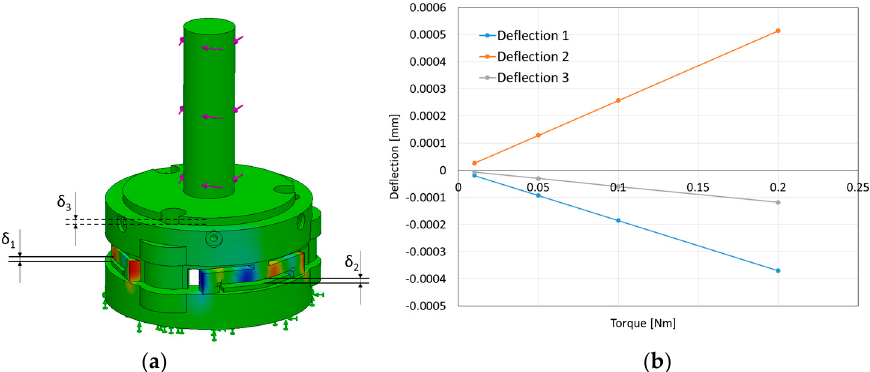
Figure 21. Effect of moment around the z-direction on sensor beam deflection. (a) Simulation; (b) Deflection of the beams as a function of applied moment.